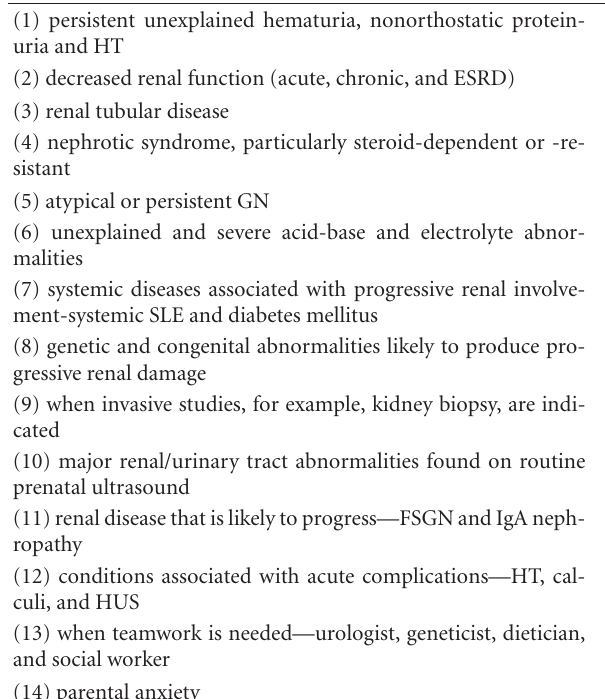
Table 2: Guidelines for patient referral to the pediatric nephrologist